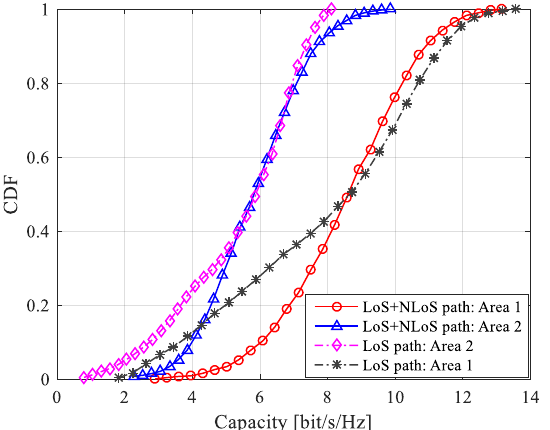
Figure 9. CDF of channel capacity for a MIMO system with double-port fed LCX considering LoS only path and both LoS and NLoS paths for different locations in the tunnel.